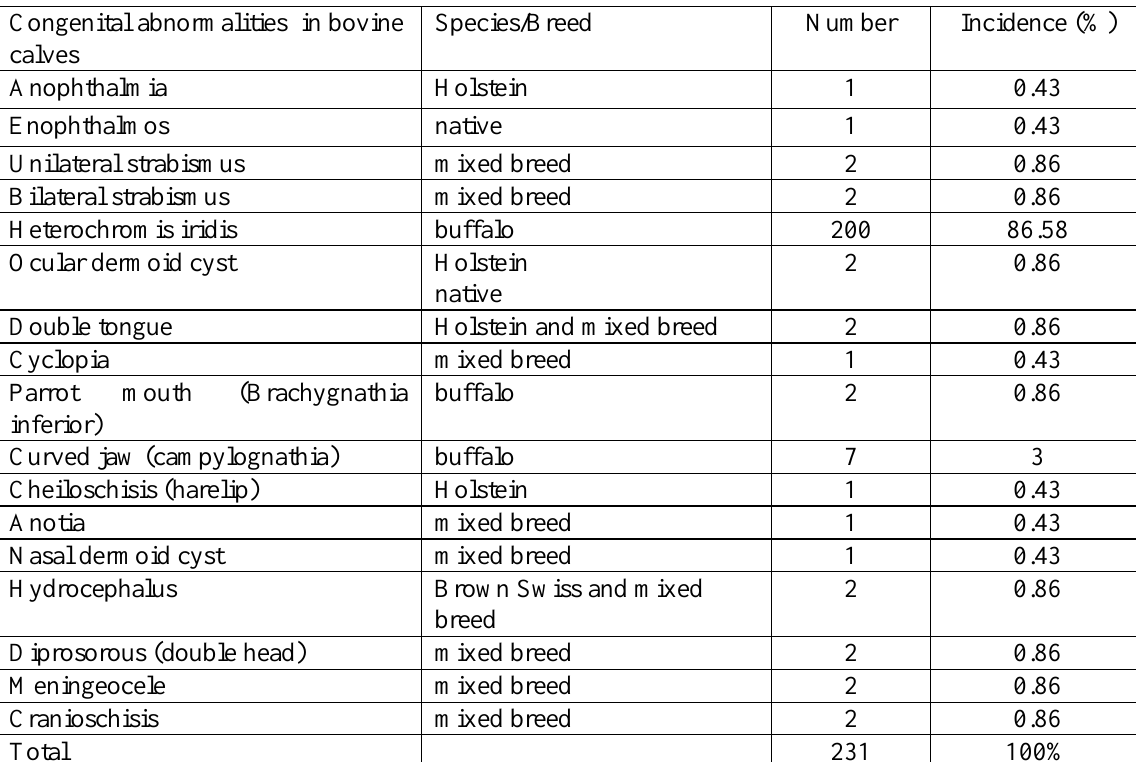
Table 1: showing breed, sex and number of newborn calves with head malformations Congenital abnormalities in bovine